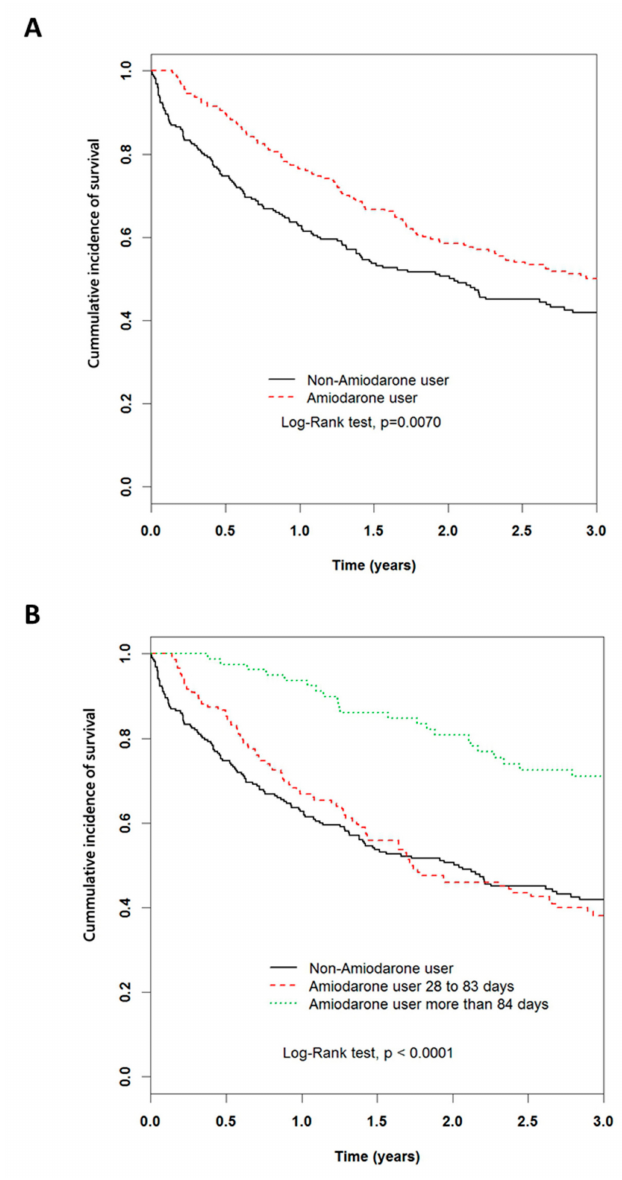
Figure 2. Cumulative incidence of survival in patients with hepatoma with the presence and absence of amiodarone by Kaplan–Meier method analysis. ( A ) 3-year Kaplan–Meier survival curves for amiodarone and non-amiodarone users. ( B ) 3-year Kaplan–Meier survival curves for amiodarone users of more than 84 days, 28–83 days, and non-amiodarone